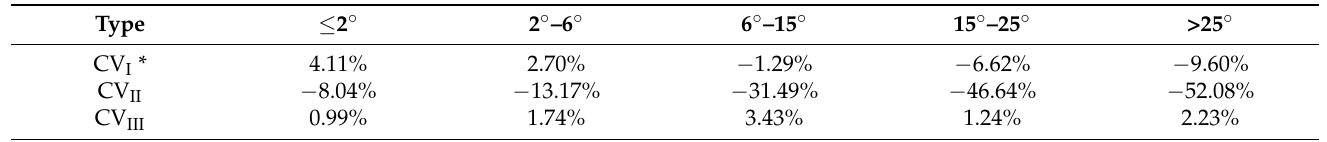
Table 4. Variation of CV with different slope.